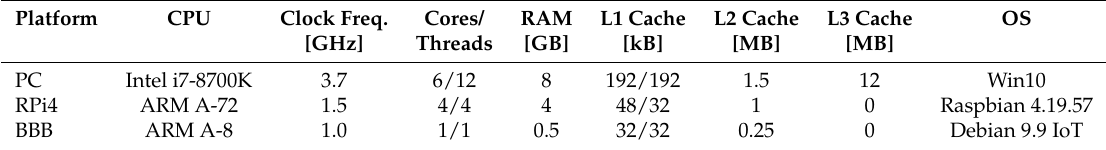
Table 6. Simulation platform